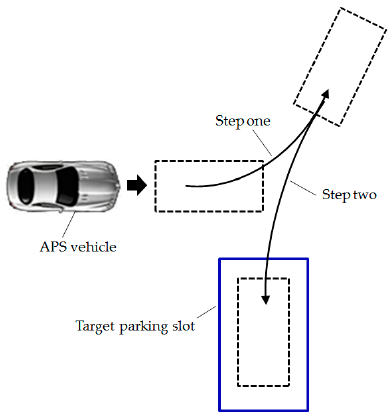
Figure 14. Common perpendicular parking process.